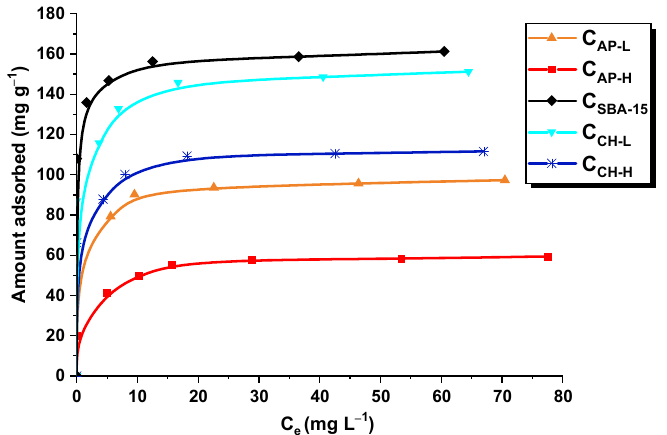
Figure 7. Adsorption isotherms of losartan potassium on the surface of C AP-L , C AP-H , C SBA-15 , C CH-L , and C CH-H carriers.